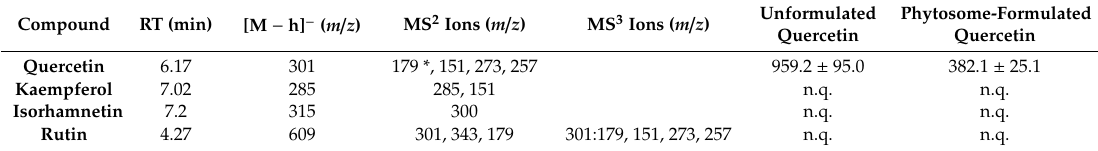
Unformulated Phytosome-Formulated Quercetin Quercetin